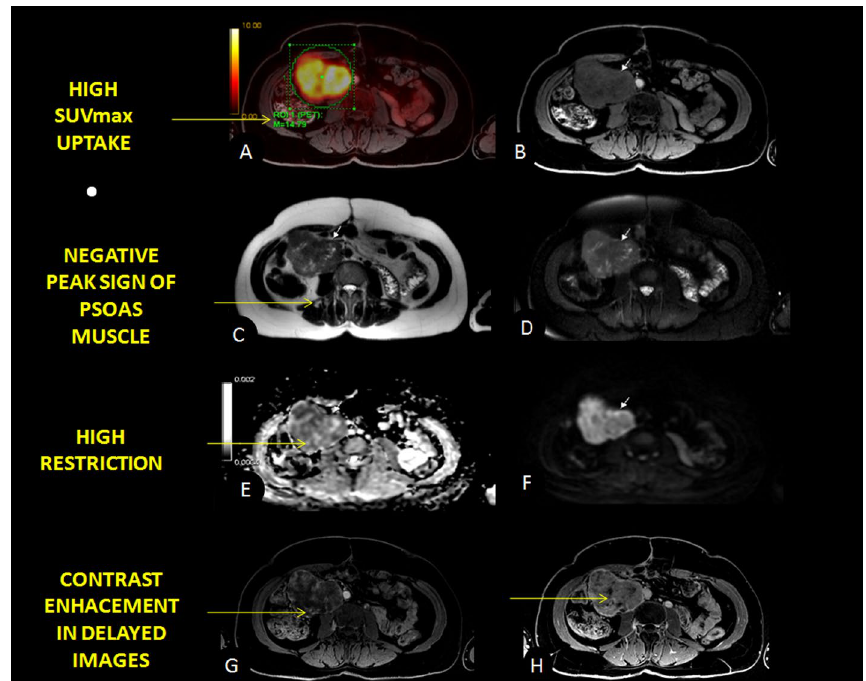
Fig. 1 PET/MRI ( A ) images illustrate solid and hypermetabolic (elevated FDG uptake SUVmax 11.91) expansive formation in the retroperitoneum. It can be seen as iso-/hypointense on T1 ( B ) and heterointense on T2 and T2 FAT SAT ( C , D respectively), with well-defined and lobulated borders. It presents a heterogeneous enhancement after IV contrast ( G ), due to necrosis areas, high restriction on diffusion images ( E – F ) and contrast enhancement intensifies in delayed images ( H ). Negative peak sign from psoas muscle was useful in the diagnosis (see description below) ( B – D